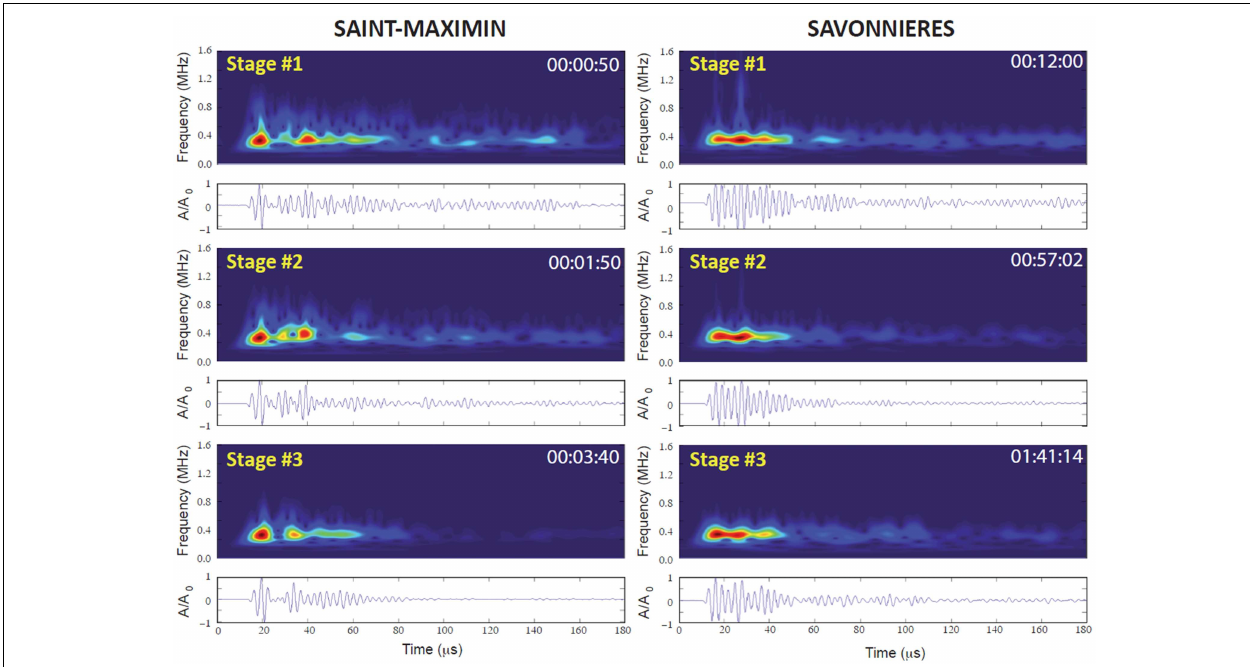
FIGURE 10 | Spectrograms and corresponding normalized waveforms obtained at different reported times on plane 1 for the Saint-Maximin and Savonnières samples.